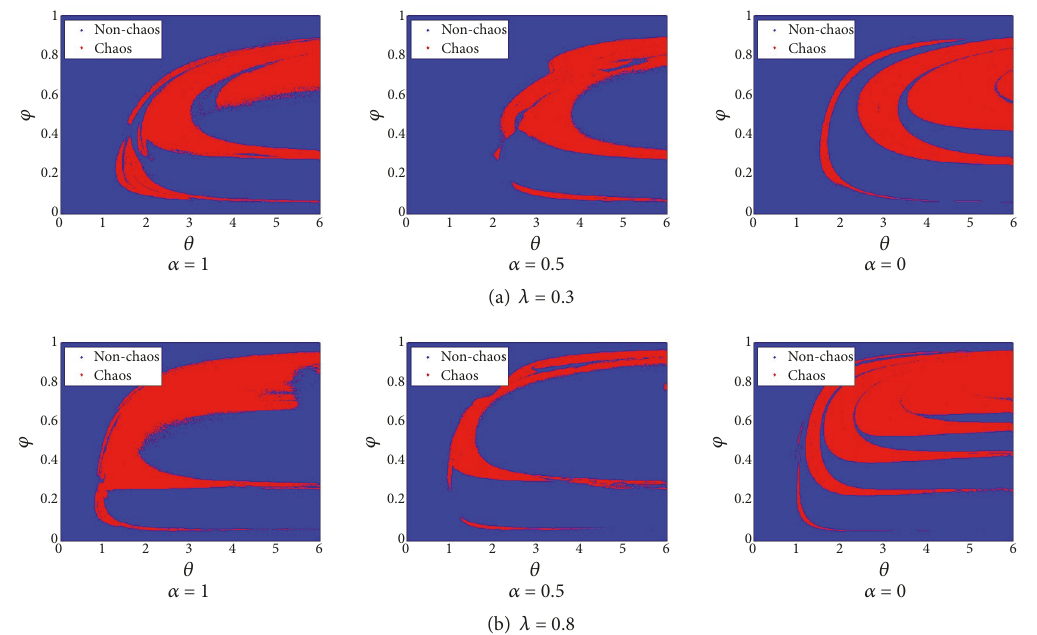
Figure 6: System state for different 𝜃 and 𝜑 for 𝜆 ( = 0.3, 0.8) and 𝛼 (=1, 0.5, 0).